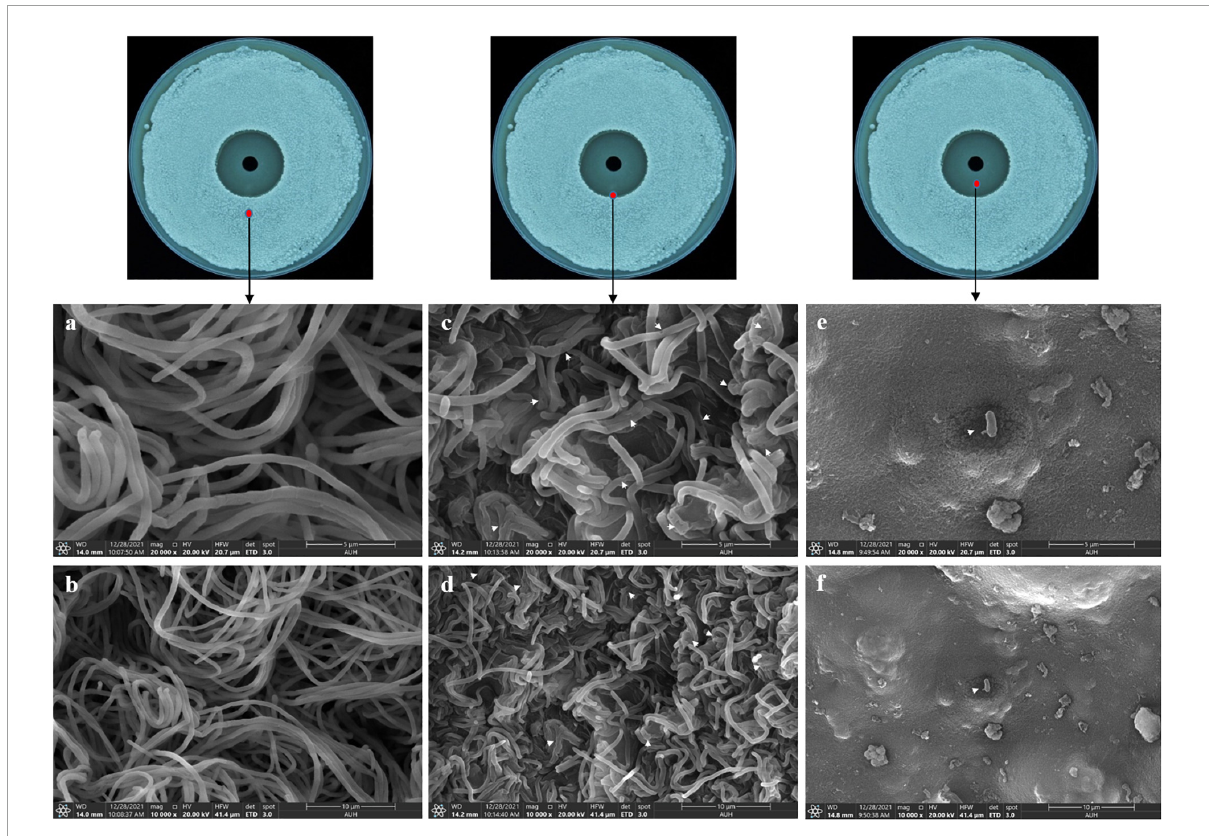
FIGURE6 Scanning electron micrographs of S. scabies treated with Lcn972. (a,b): non-inhibition zone; (c,d): edge of the inhibition zone; (e,f): inhibition